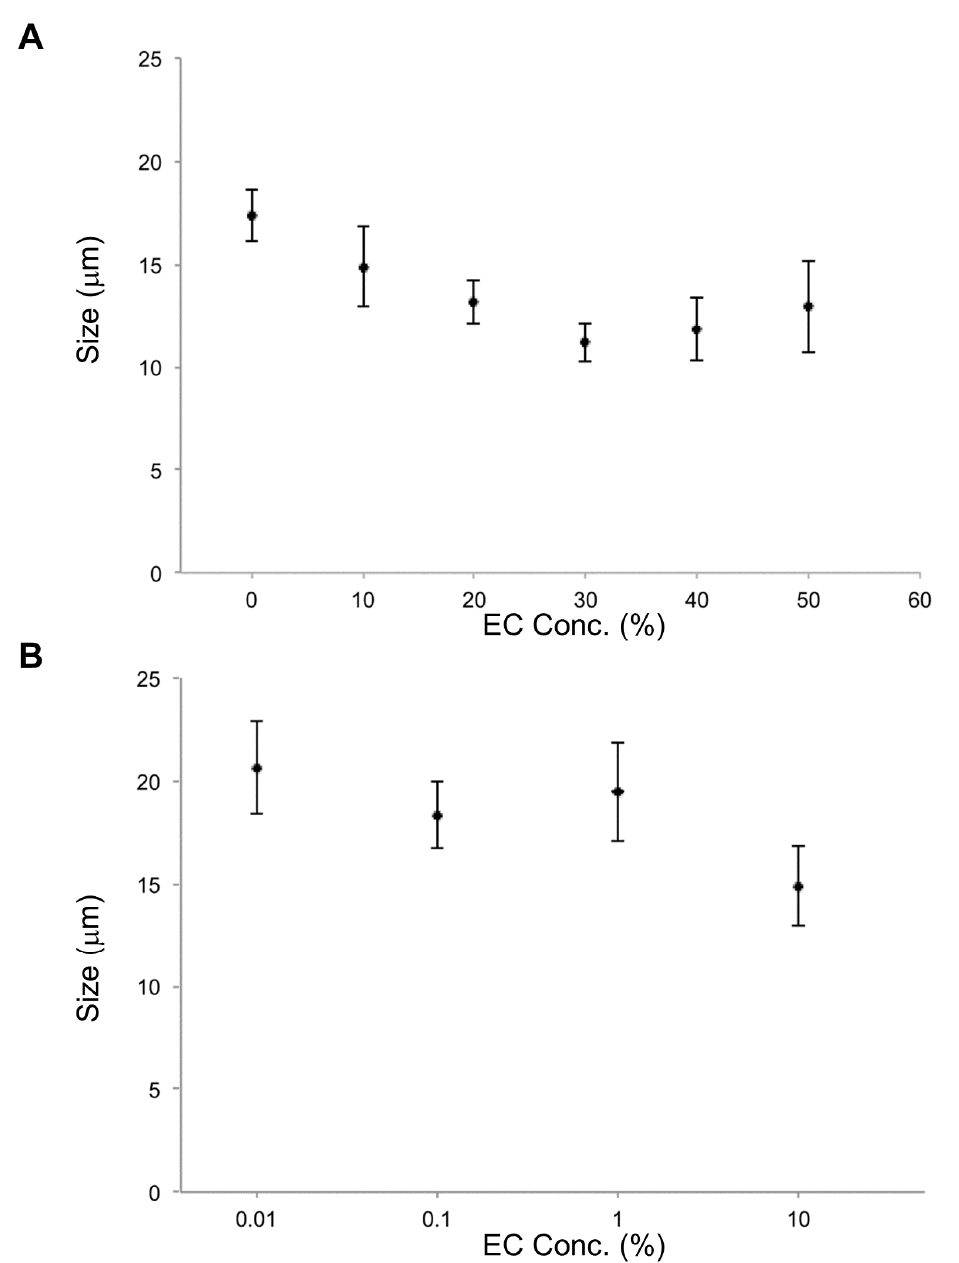
Figure 3. Size of lipid vesicles made from membranes containing ethyl caproate (EC) at different concentrations: ( A ) 0% to 50%, ( B ) 0.01% to 10%.